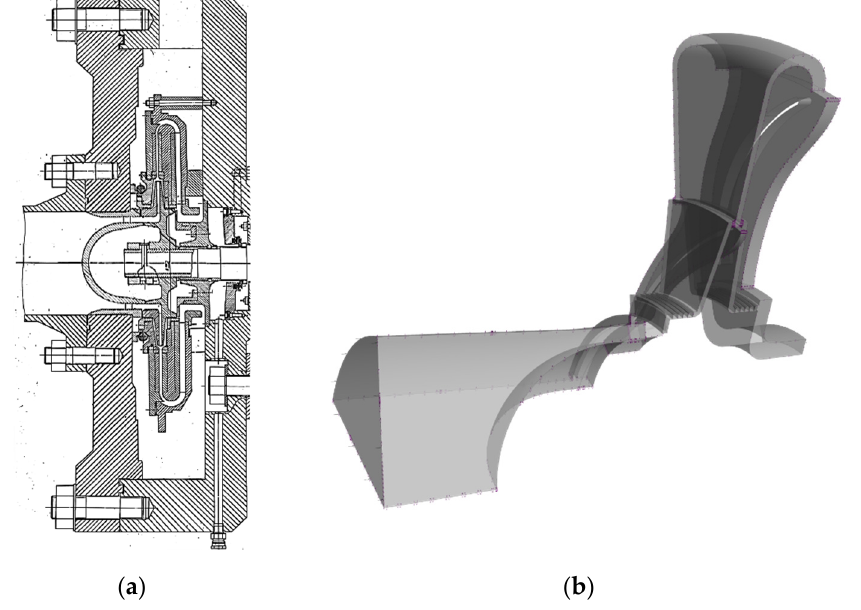
Figure 8. ( a ) Experimental setup a closed loop and ( b ) numerical model of the HPS-7 stages.